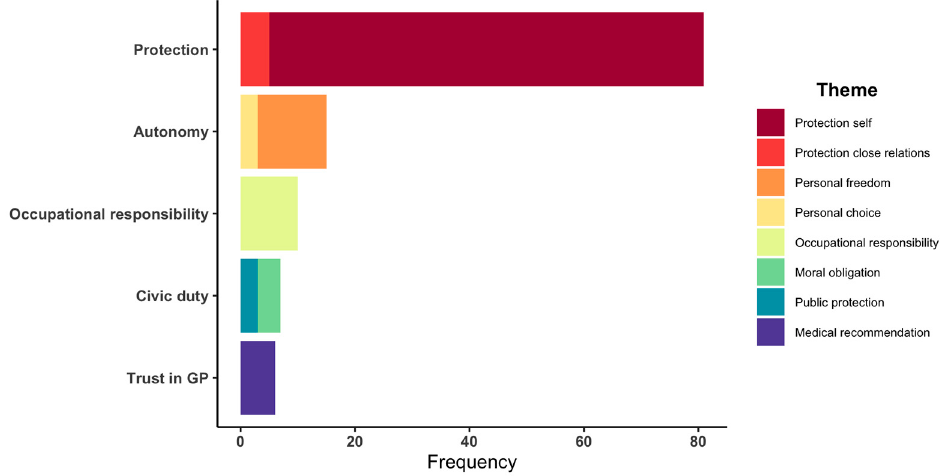
Figure 3. Frequency of motivations related to COVID-19 vaccination.